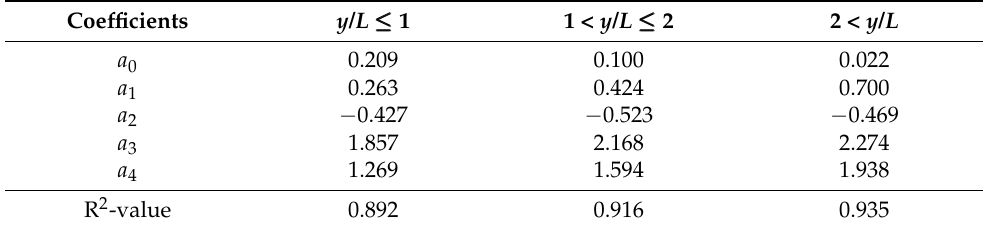
Figure 5. Method of superposition for computing the abutment scour evolution under a stepwise hydrograph. Table 3. Summary of coefficients used in Equation (1).